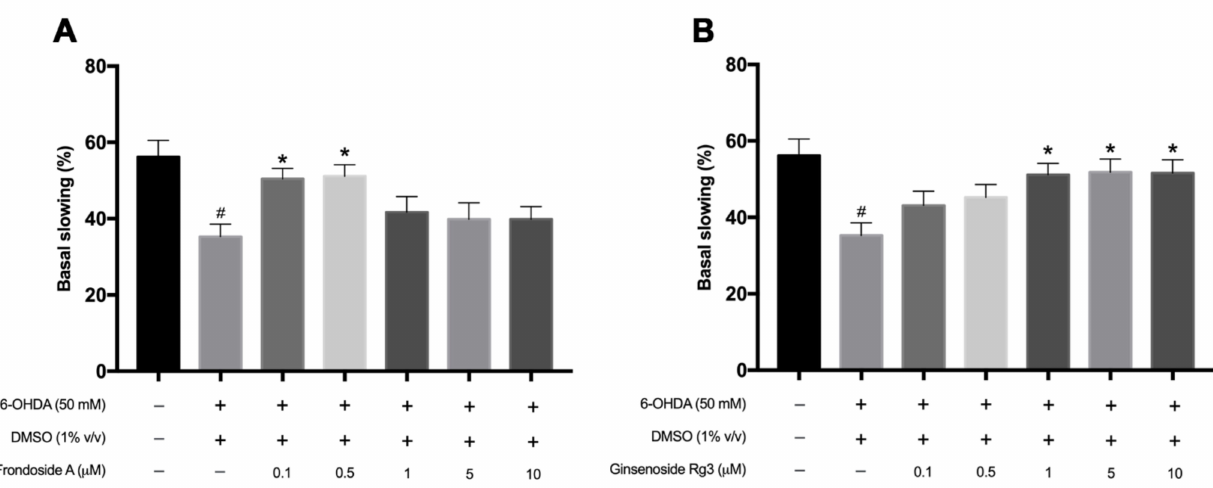
Figure 4. Graphical representations for the basal slowing rate in 6-OHDA-induced N2 C. elegans treated with FA ( A ) and Rg3 ( B ). The hash (#) indicates a significant difference between 6-OHDA-induced and uninduced worms ( p < 0.05). The asterisk (*) indicates a significant difference between the 6-OHDA-induced control worms and the FA/6- OHDA- or Rg3/6-OHDA-treated worms ( p < 0.05). The experiment was performed independently at least three times (number of worms = 40–50 animals/group per